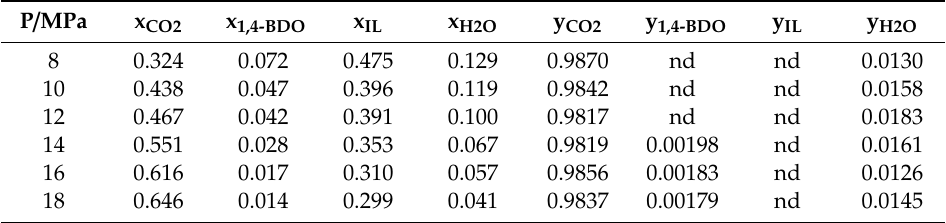
Table 1. Vapour-liquid equilibrium data for the quaternary (CO 2 + 1,4 BDO + [hmim][B(CN) 4 ] + H 2 O) system at 313.2 K 1